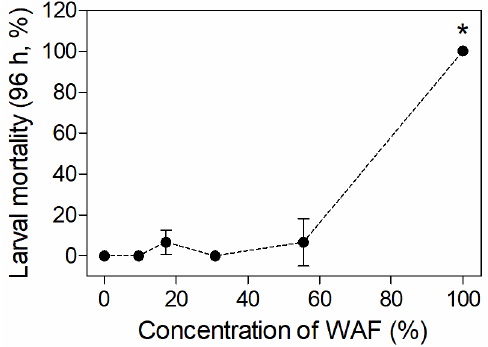
Figure 1. Mortality of marine medaka larvae after 96 h of exposure in acute test ( n = 3). The symbol * indicates significant difference of the treatment compared to the control ( p < 0.05).